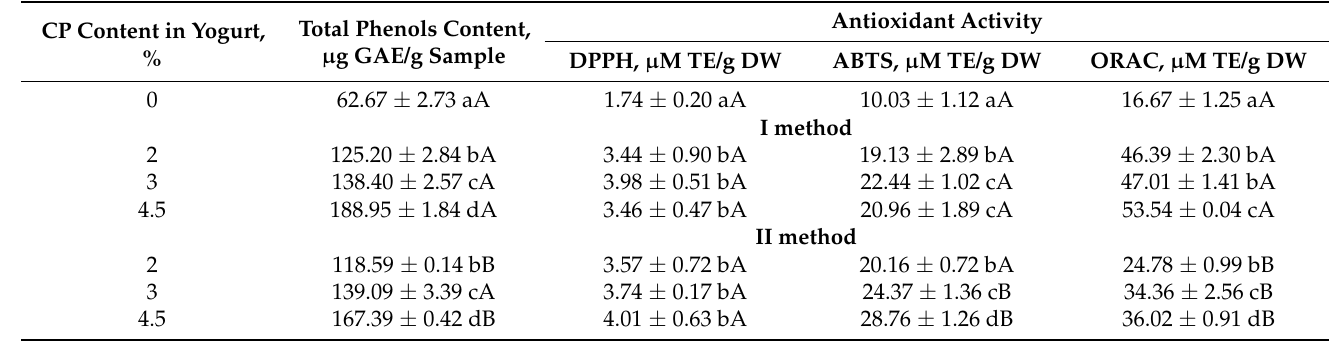
Table 3. Total phenols content and antioxidant capacity of yogurt made by adding different amounts of CP after (I method) and before fermentation (II